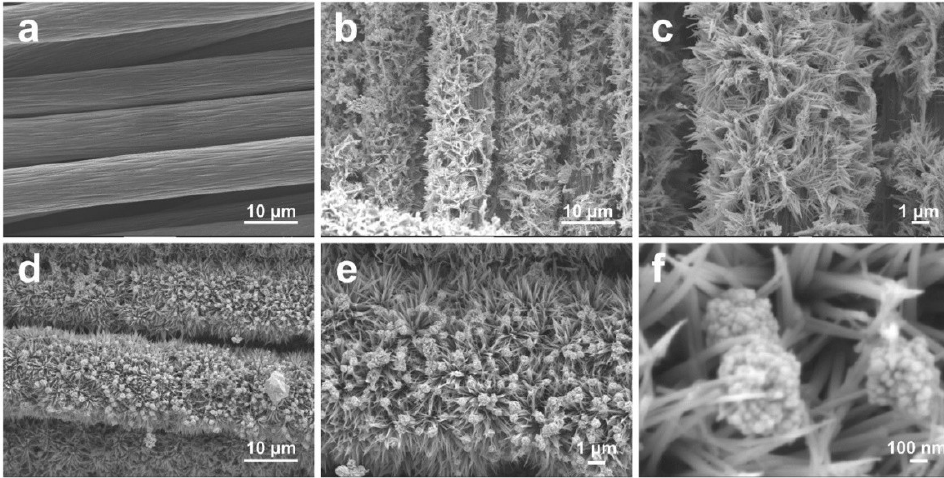
Figure 1. SEM images of samples of ( a ) CC, ( b , c ) NiCo 2 O 4 -NC and ( d – f ) Ag/NiCo 2 O 4 -NC.